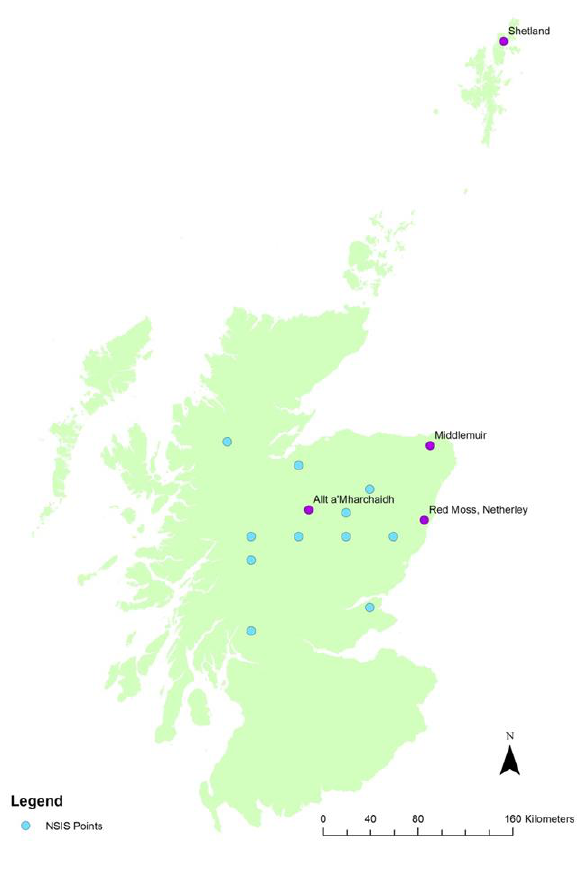
Figure 1. Locations of peat sampling sites within